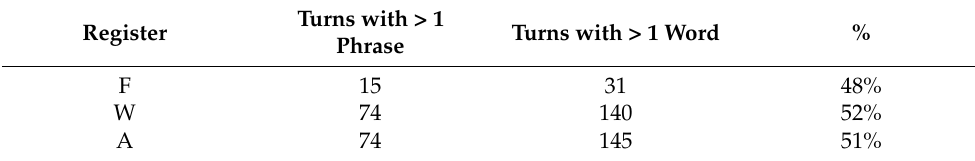
Table 4. Incidence of turn-internal phrasing boundaries, by register.